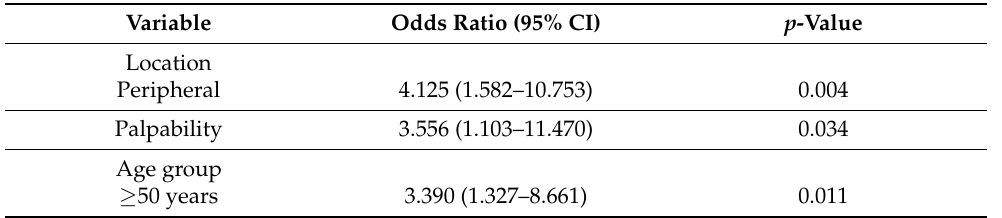
Table 3. Multivariate logistic regression analysis to determine the risk factors associated with malignant papillary breast